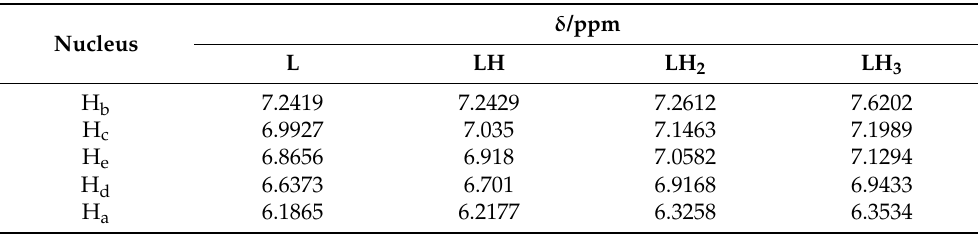
Table 4. Calculated chemical shift ( δ /ppm) of different (de)protonated species of CFA, in KCl (aq) at I = 0.2 mol · dm − 3 and T = 298.15